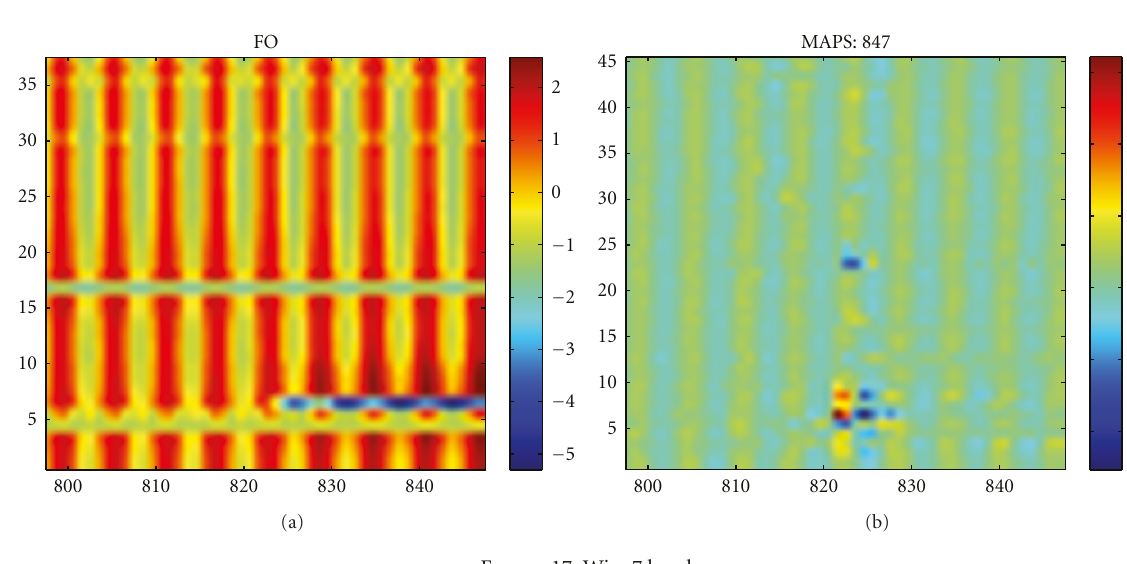
Figure 16: Wire 17 break.